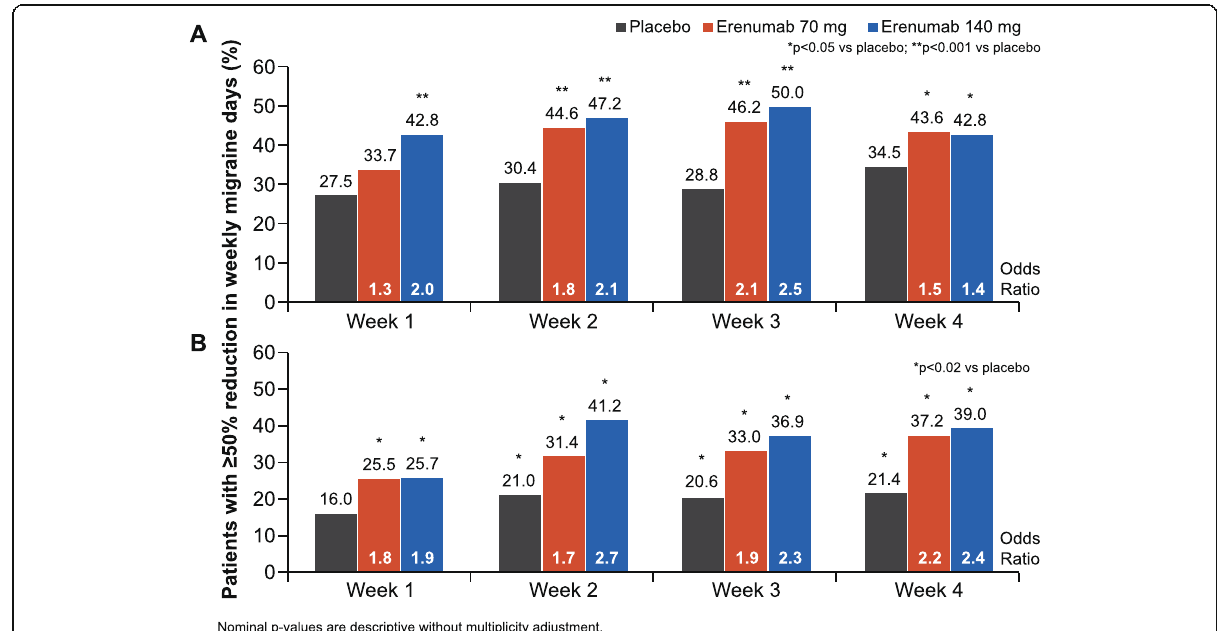
Fig. 3 Proportion of patients with ≥ 50% reduction from baseline in WMD during the first month of studies in episodic migraine ( a ) and chronic migraine ( b